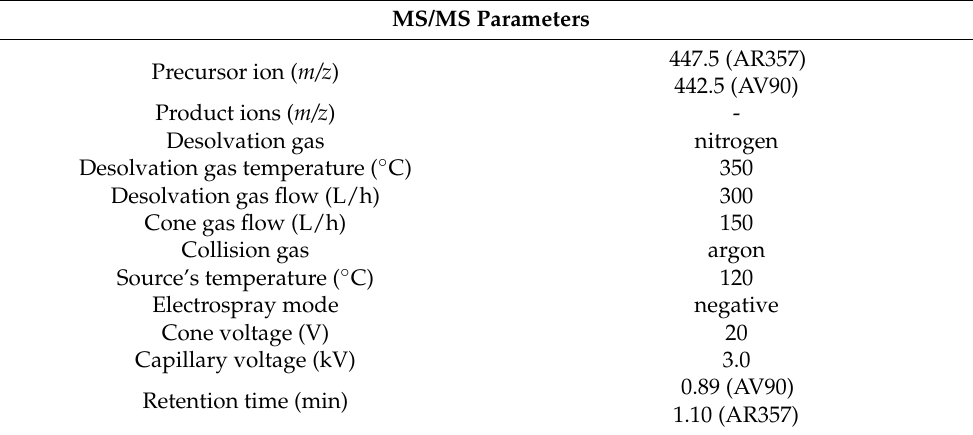
Table 2. Tandem mass spectrometry (MS/MS) parameters.